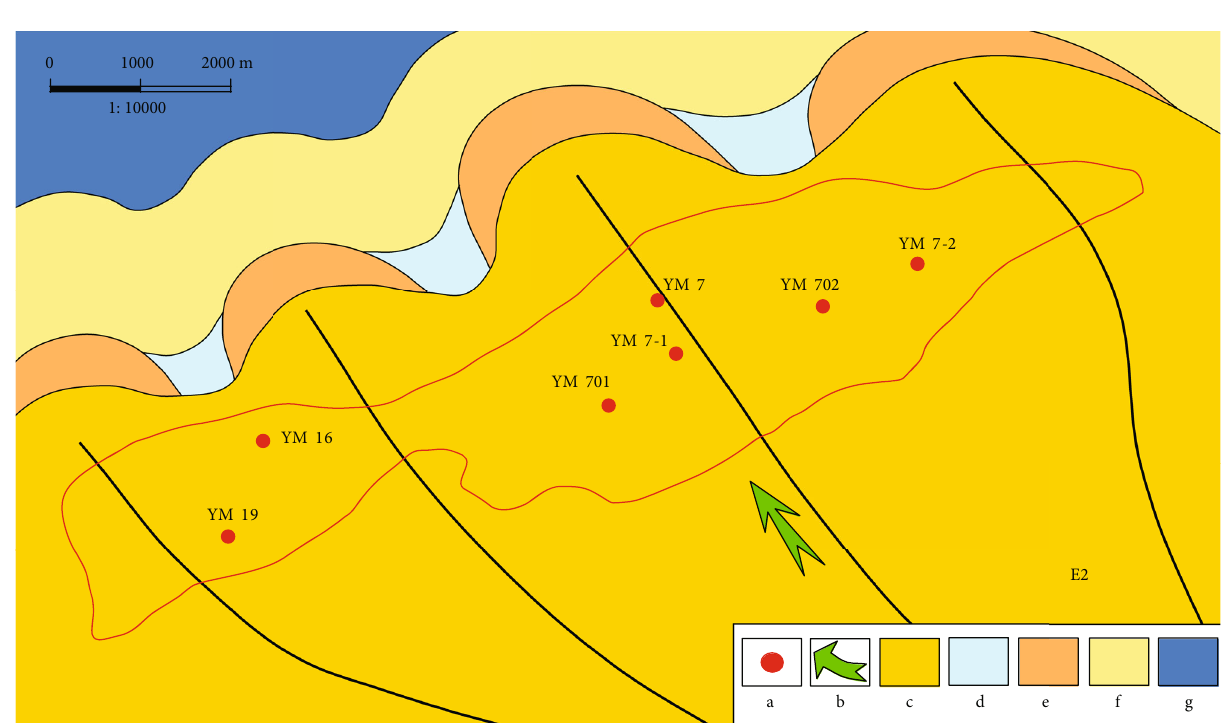
Figure 7: Plane distribution of sedimentary microfacies of layer E2 in Yingmai 7 block: (a) well location; (b) provenance direction; (c) underwater distributary channel; (d) underwater distributary bay; (e) mouth bar; (f) front edge sheet sand; (g) shallow lake mud.